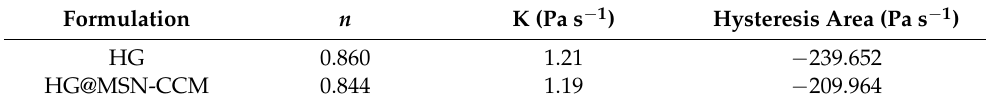
Figure 6. Oscillatory analysis of the HG@MSN-CCM: analysis performed at 25 °C ( A ) and analysis performed at 32 °C ( B ). Storage modulus G ′ (red symbols) and loss modulus G ″ (blue symbols).